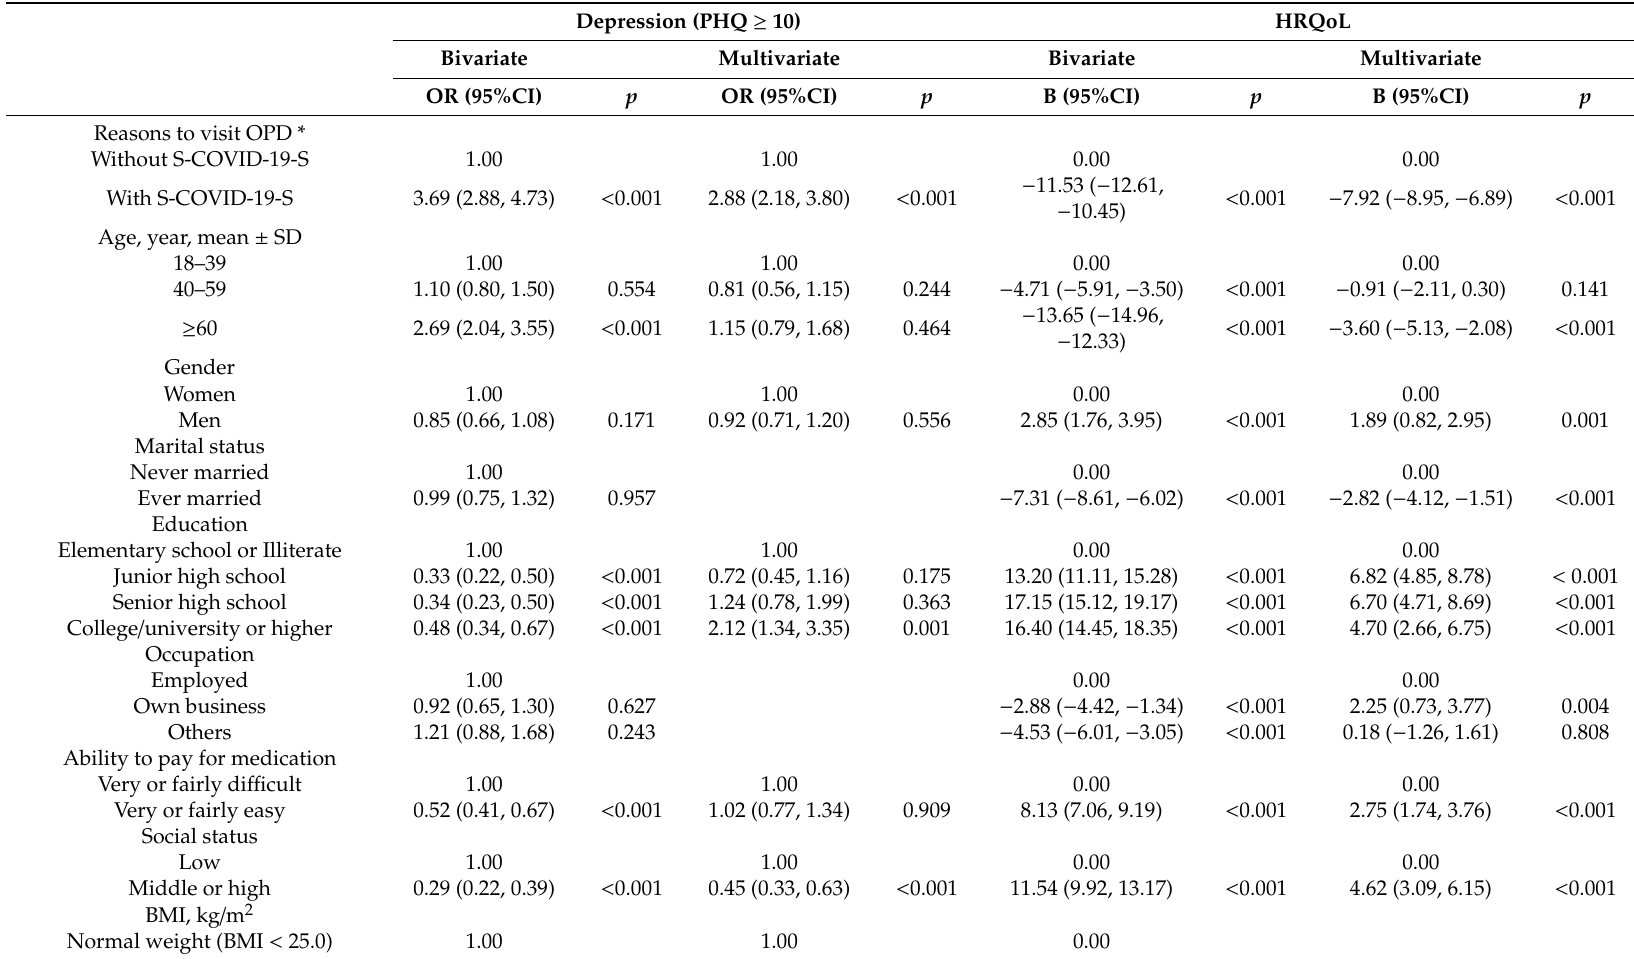
Table 2. Determinants of depression and health-related quality of life among people visiting outpatient department ( n = 3947). Depression (PHQ ≥ 10) HRQoL Bivariate Multivariate Bivariate